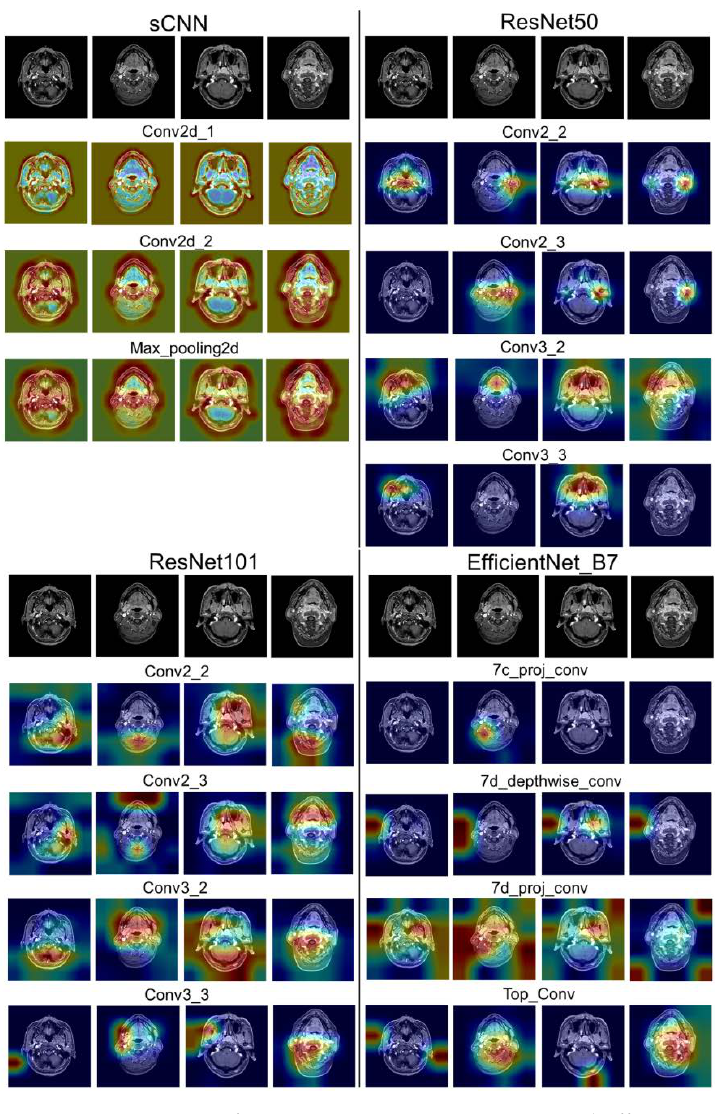
Figure 8. Feature maps for sCNN, ResNet50, ResNet101, and EfficientNet-B7 for normal control and patient. Left two for normal and right two for patients. The top row is for the original images and the bottom row is for the convolutional layers adjacent to the output layers.